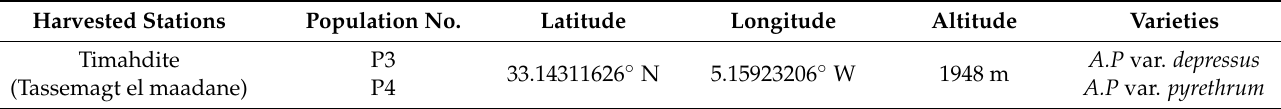
Table 1. Contact details for the harvested sites. Harvested Stations Population No. Latitude